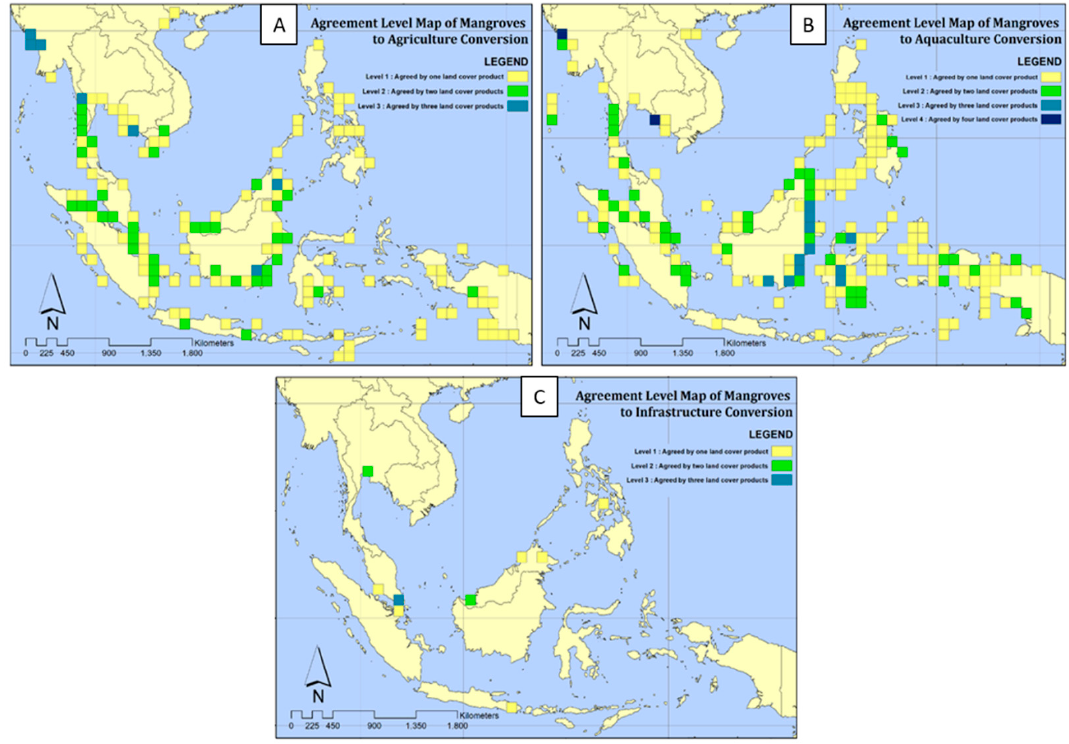
Figure 7. Confidence levels for land cover class conversion of mangrove forest. ( A ) Agreement level of mangroves to agriculture. ( B ) Agreement level of mangroves to aquaculture. ( C ) Agreement level of mangroves to infrastructure.